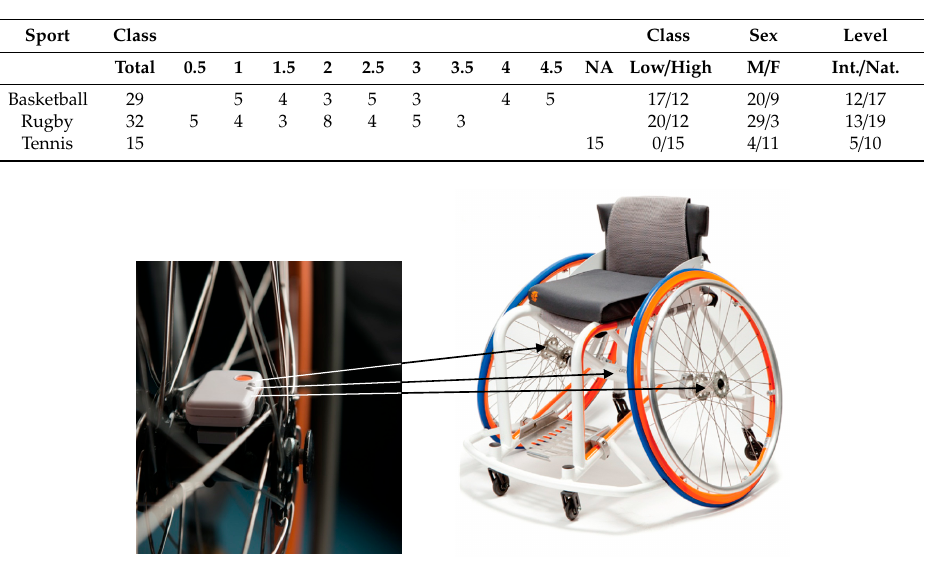
Figure 1. Sensor placement on the wheelchair, with one on each wheel axle and one on the frame camber bar (sensor picture by Marc Hollander Photography: www.marchollander.nl).